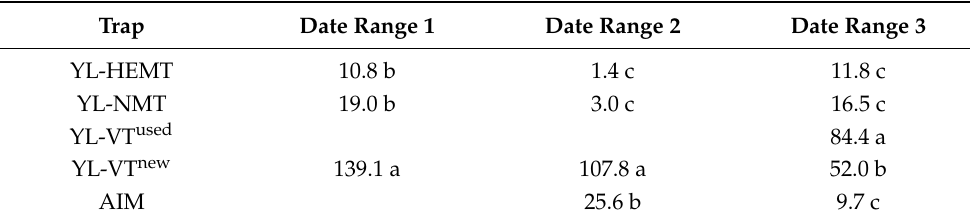
Table 4. Multiple comparisons of moths trapped by different traps (head per day) in